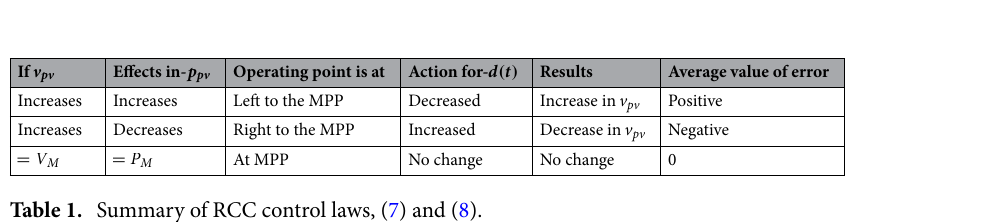
Figure 8. Architecture of 1st-level of the proposed 2-level MPPT control (RCC) 11 .